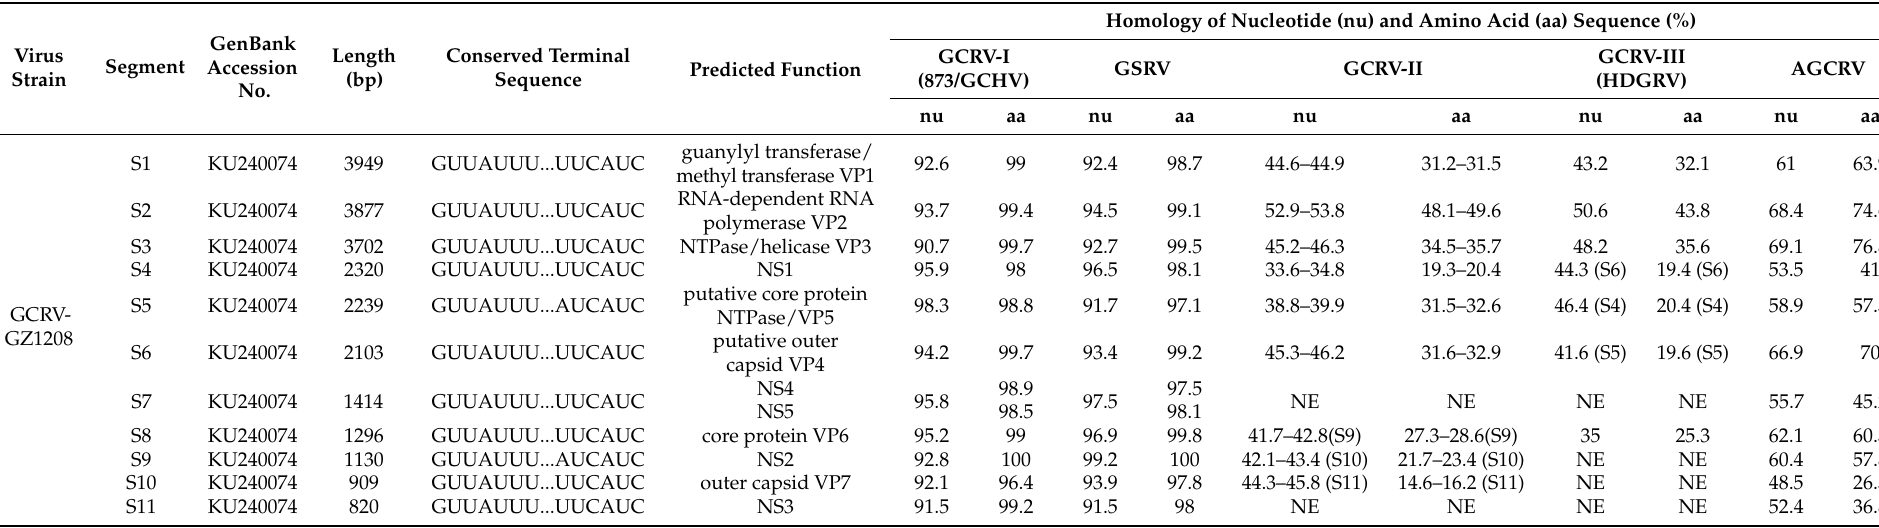
Table 1. Characteristics of genome segments and percent identities of homologous genome segments and encoded proteins between isolate GZ1208 and other GCRV strains and GSRV.